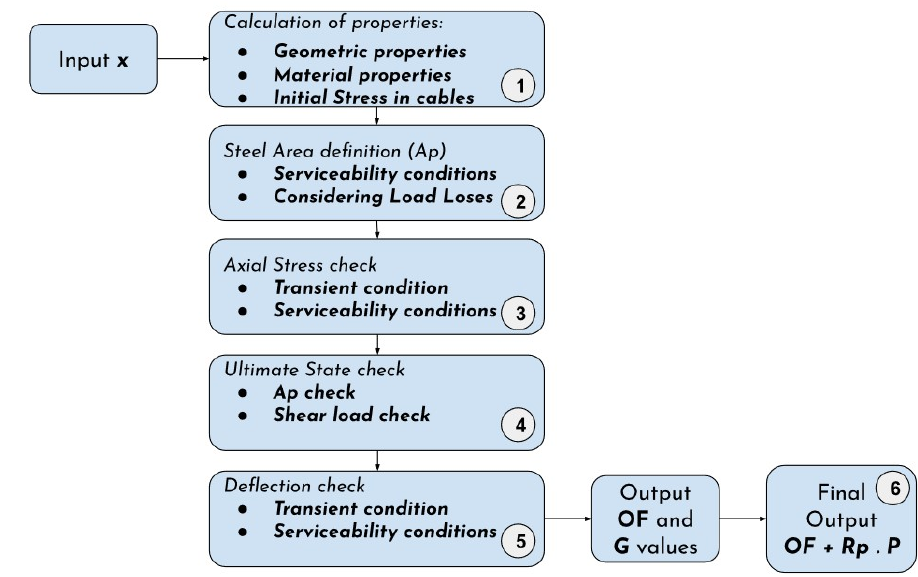
Figure 4. Flowchart of the objective